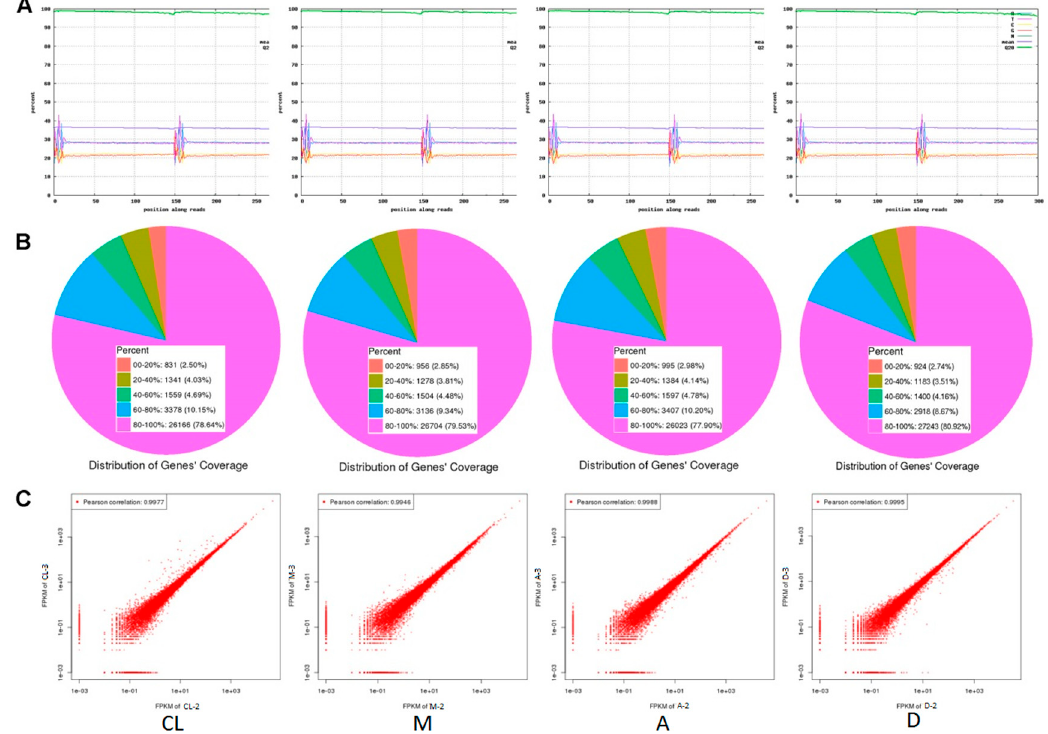
Figure 2. Transcriptome sequencing quality analysis between treatments and control. ( A ) Base composition and quality distributions. ( B ) Statistic maps of gene coverage. ( C ) Correlation coefficient maps between different sequencing repeats.